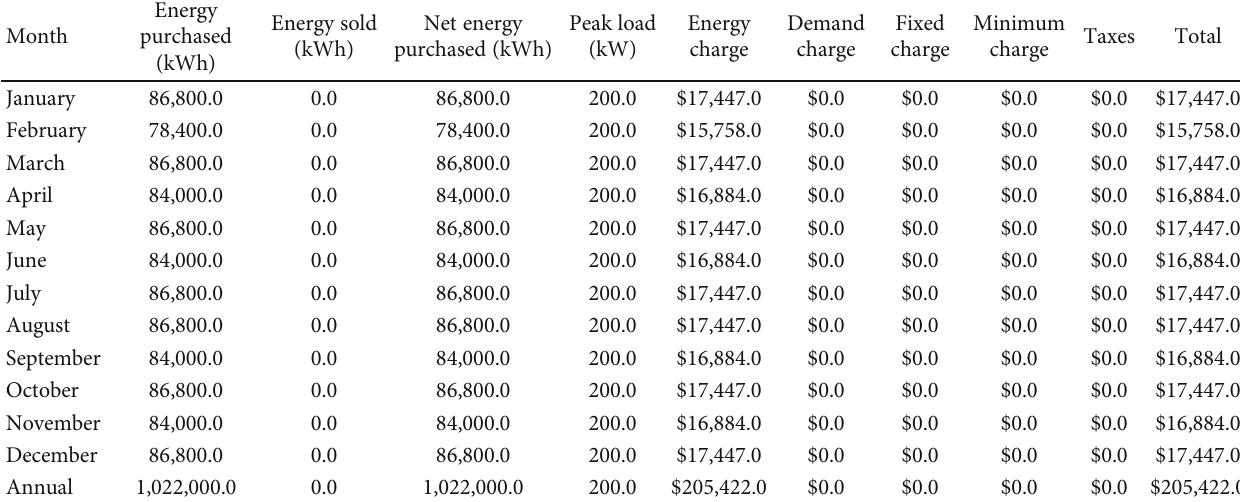
Table 9: Utility monthly summary — current system (Kenya).